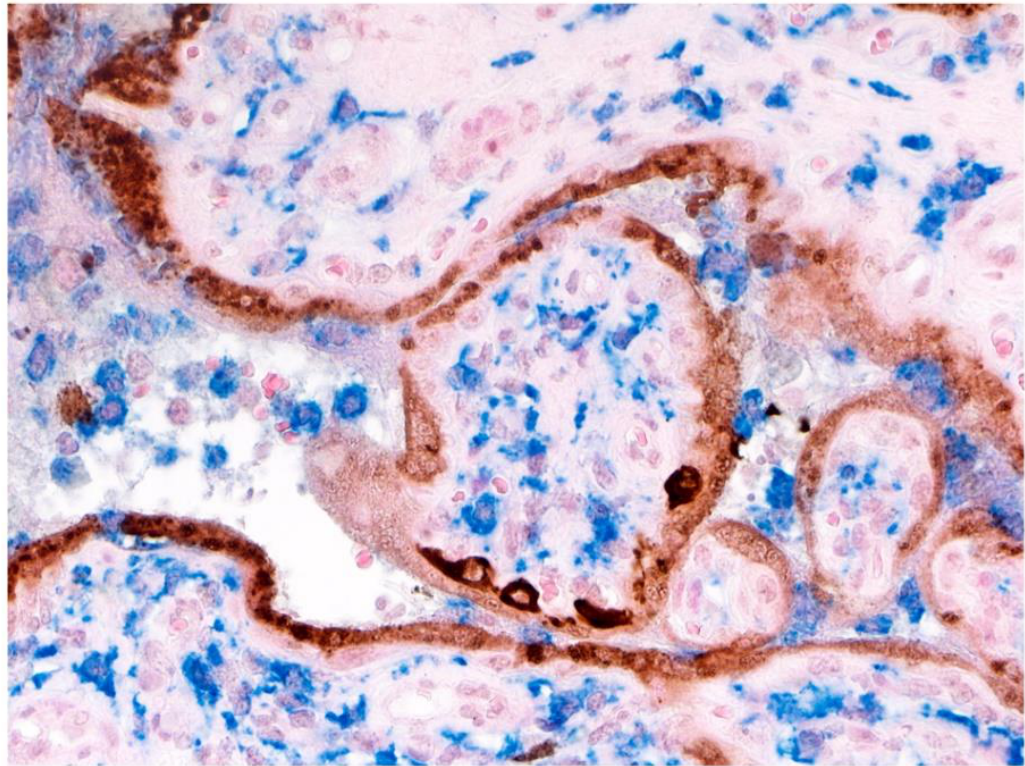
Figure 4. Double-staining using CD163 antibody to macrophages (blue) and antibody to SARS-CoV-2 nucleocapsid protein (brown) demonstrates dark brown-staining cytotrophoblast cells subjacent to light-brown staining syncytiotrophoblast, and their relationship with the villous stromal macrophages (blue), termed Hofbauer cells. Double staining with antibodies to CD163 and SARS-CoV-2 nucleocapsid protein, nuclear red counterstain, ×40. Double-staining immunohistochemistry using antibodies to GATA3 and SARS-CoV-